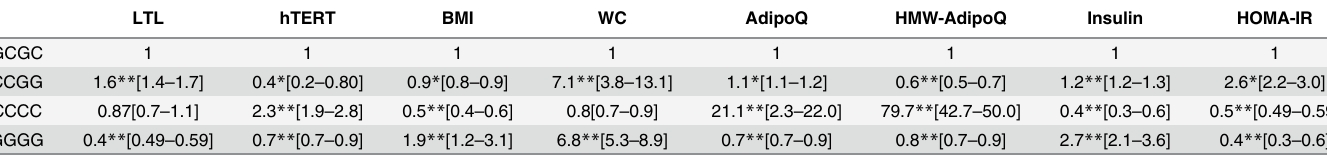
(Table 4). On the other hand, [ CC ] haplotype was significantly associated with higher hTERT levels but not with LTL. Additionally, [ GG ] haplotype was found to be associated with lower risk of shorter LTL and higher levels of hTERT in contrast to [ CG ] haplotype as shown in Table 4. [ CG ] haplotype was significantly associated with larger WC. In accordance with the high WC, [ CG ] haplotype was significantly associated with higher HOMA-IR. [ CC ] and [ GG ] haplotypes showed the opposite trends to haplotype [ CG ]. In fact [ CC ] haplotype was signifi- cantly associated with higher total AdipoQ and HMW-AdipoQ levels (Table 4). This probably explains the negative association reported in those haplotypes with HOMA-IR and insulin levels. Table 4. ORs [95%CI] for associations of haplotypes with LTL, hTERT, anthropometric indices and metabolic factors of